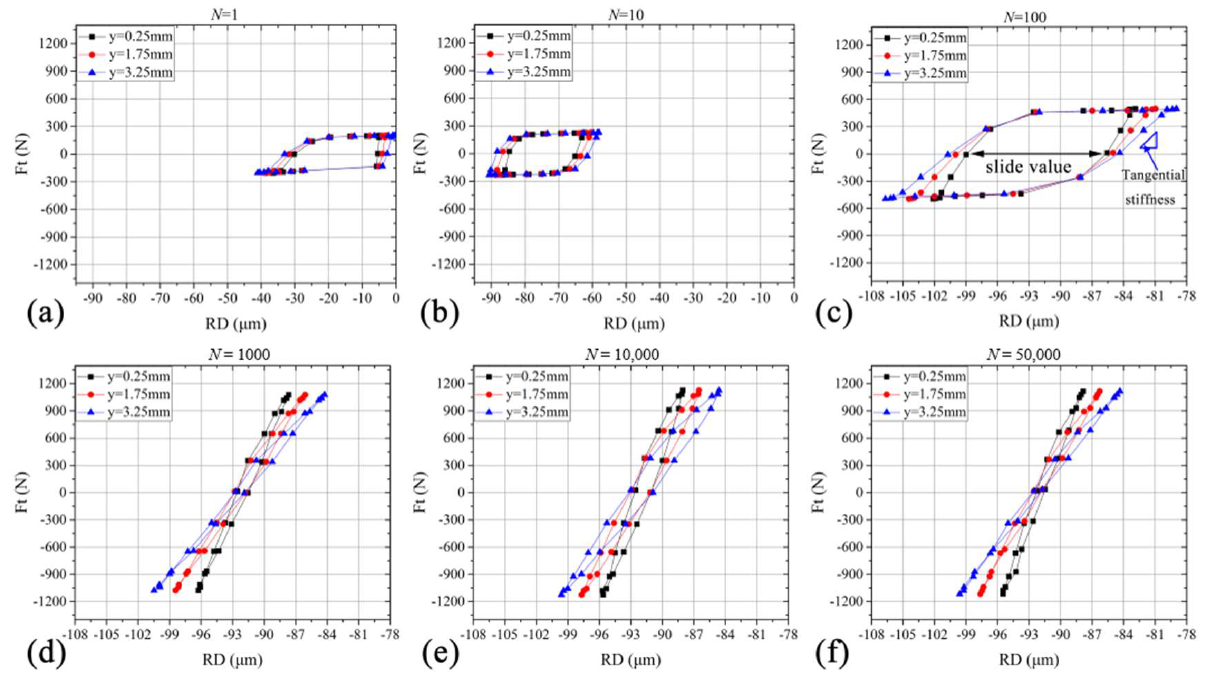
Figure 8. Hysteresis loops of tangential force ( F t) in a function of relative displacement (RD) for the 8.5 kN case: ( a ) N = 1, ( b ) N = 10, ( c ) N = 100, ( d ) N = 1000, ( e ) N = 10,000, and ( f ) N =